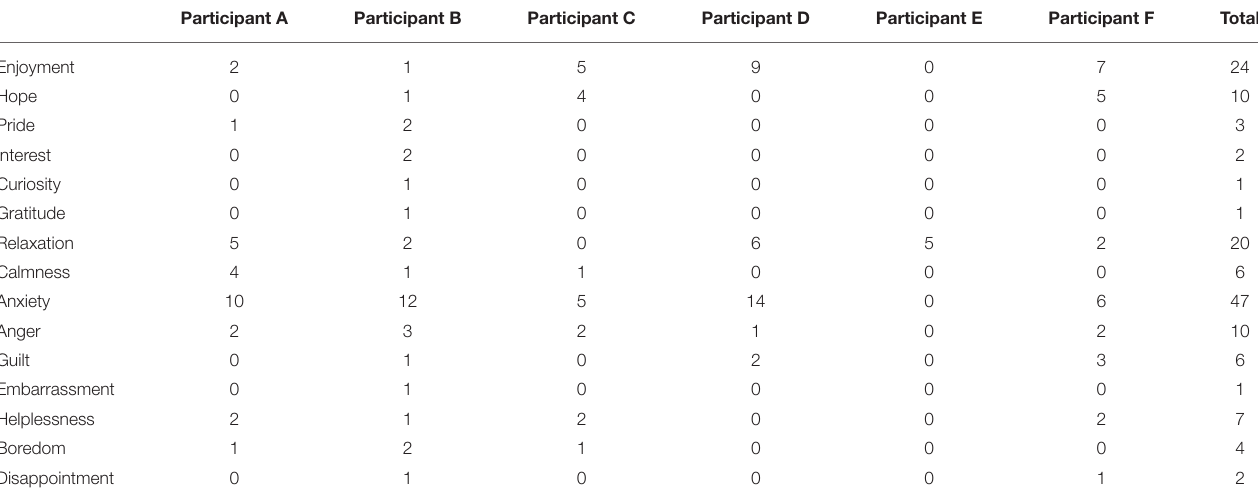
TABLE 5 | Emotions experienced by the six participants and the frequency of quotes. Participant